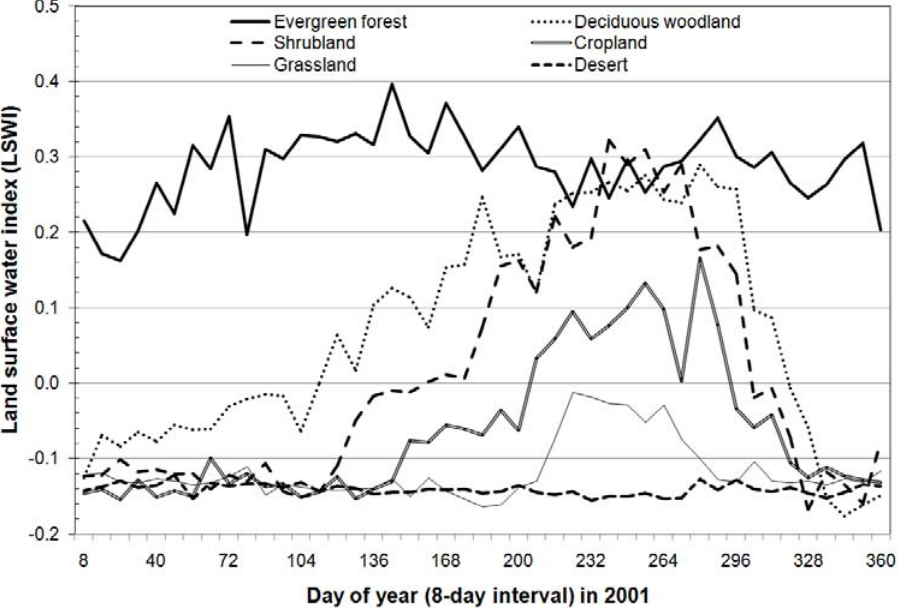
Figure 1. The seasonal dynamics of Land Surface Water Index (LSWI) in 2001from six sites that represent major land-cover types in the tropical Africa. The evergreen forest site (20.9086 ° E, 2.3042 ° S) was located at the Salonga national park of Democratic Republic of Congo [IUCN/WWF (1985)]; the deciduous woodland site (3.8437 ° W, 9.4417 ° N) at the Comoé National Park of Côte d'Ivoire; the savanna shrubland site (2.4341 ° E, 11.7463 ° N) at the Benin National Park of Republic of Benin (http://sea.unep-wcmc.org); the cropland site (8.3158 ° E, 12.2098 ° N) in Nigeria (selected from an IKONOS image of November 7, 2000); the savanna grassland site (30.4783 ° E, 12.2829 ° N) at the CO flux tower site in Demokeya, 2 Sudan (http://www.fluxnet.ornl.gov/fluxnet); and the desert site (28.2478 ° E, 18.2083 ° N) in Sudan. The vegetation index data in this Figure are the original data, including cloudy observations. Cloudy observations have low NDVI